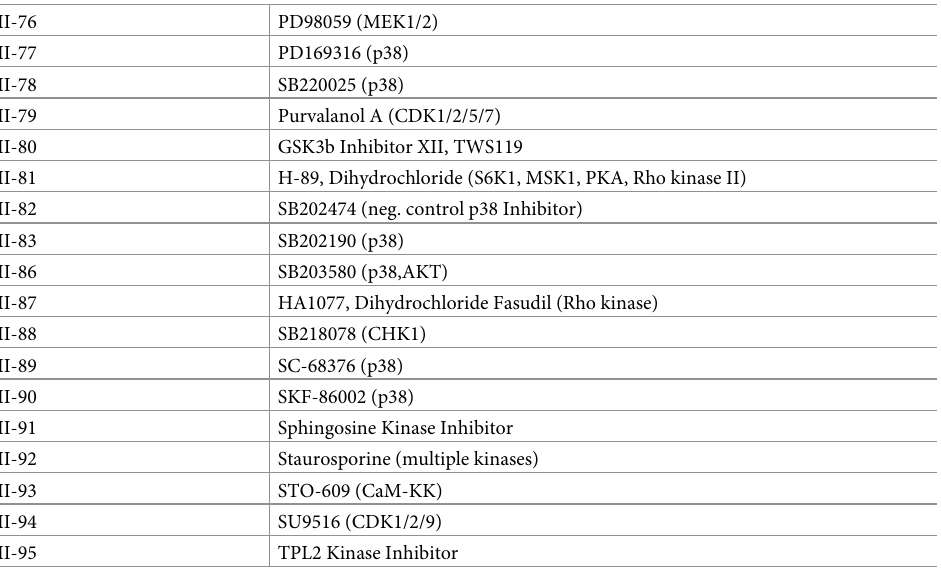
for two Library II inhibitors: II-68, MEK inhibitor II; and II-81, H-89 (PKA inhibitor).